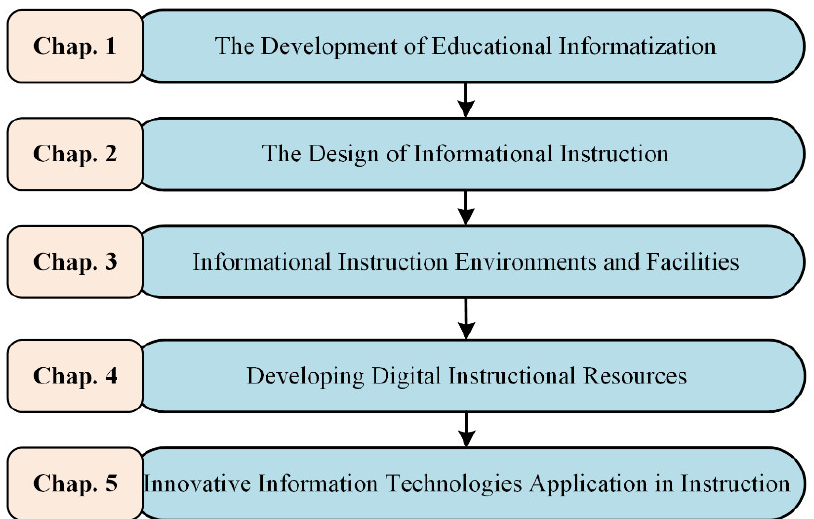
Figure 4. The topics of every chapter of the online course.